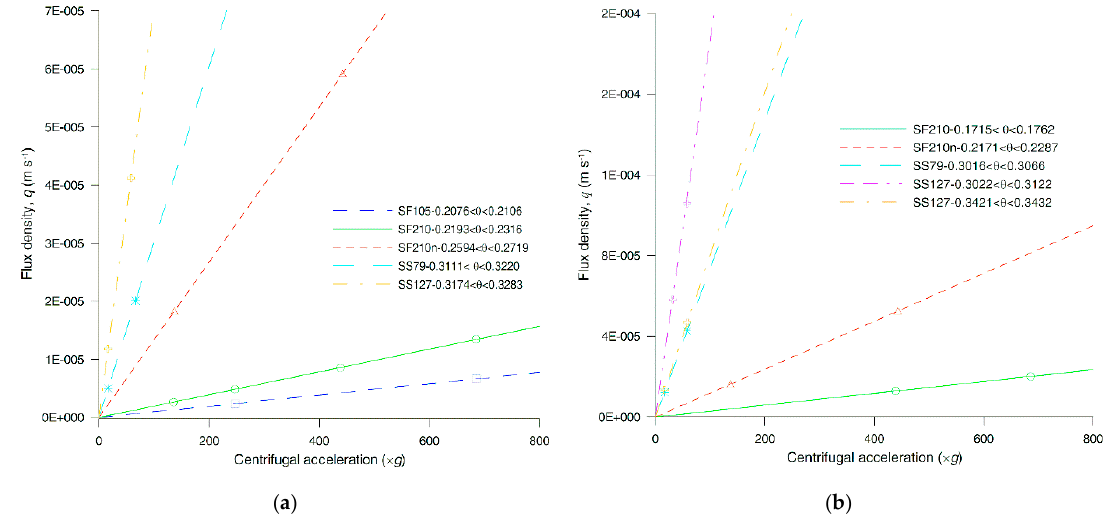
Figure 13. Flux density vs. centrifugal acceleration: ( a ) lithotypes C; ( b ) lithotype M. The samples were tested with different flow-controlling cakes, water contents, and centrifugal forces. The line is a least squares regression on points up to 800 × g .